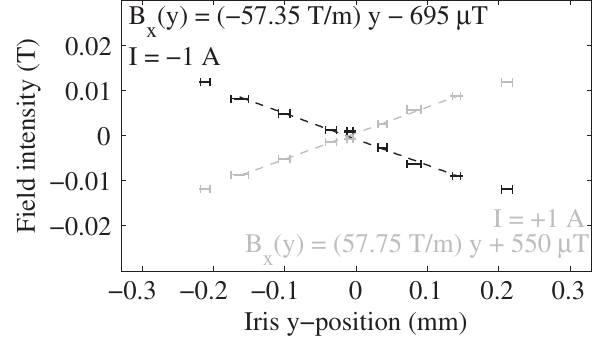
FIG. 11. X-axis transverse field profile measured with a 0.02 mm electron beam probe. Error bars and regression lines show the field across the center of the gap. 54 . 3 T = m gradients at 1 A are expected from FEM simulations.